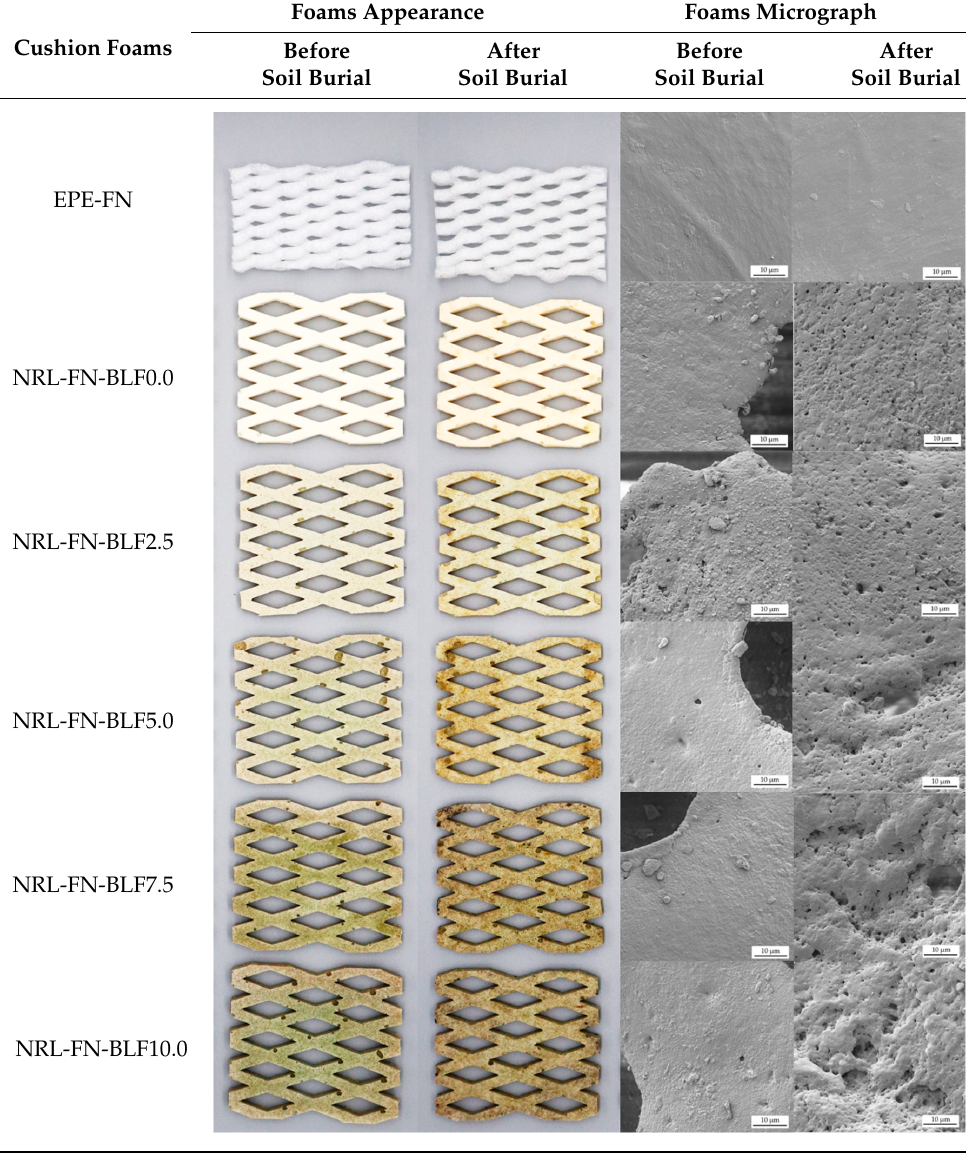
Table 4. Appearance and micrograph of cushion foams before soil burial (0 weeks) and after soil burial (24 weeks). Foams Appearance Foams Micrograph Before After Before After Soil Burial Soil Burial Soil Burial Soil Burial